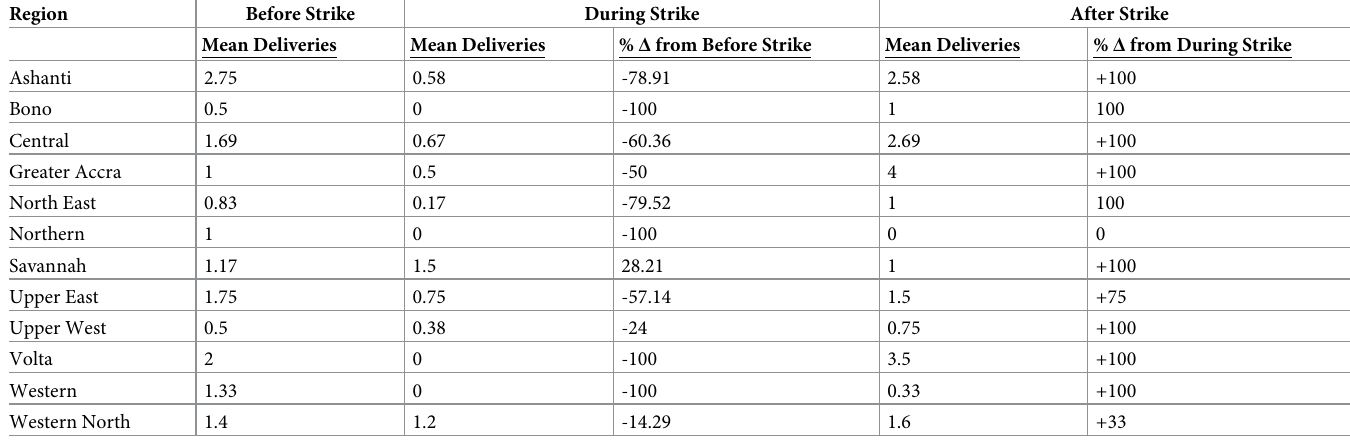
Table 13. Percentage change in the mean deliveries conducted during and after strike. Region Before Strike During Strike After Strike Mean Deliveries Mean Deliveries % Δ from Before Strike Mean Deliveries Ashanti